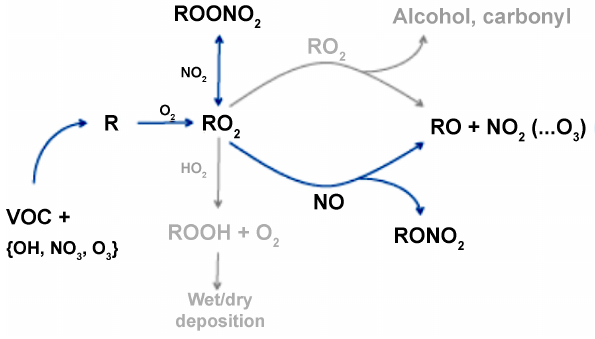
Figure 1. A schematic of the atmospheric chemical system (Atkin- son and Arey, 2003; Palmer et al.,